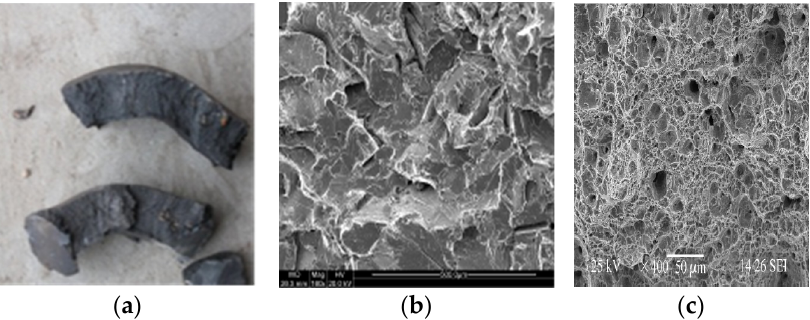
Figure 14. Shear characters and metallography of fragment surface. ( a ) Fragment of section; ( b ) Metallographic 1; ( c ) Metallographic 2.